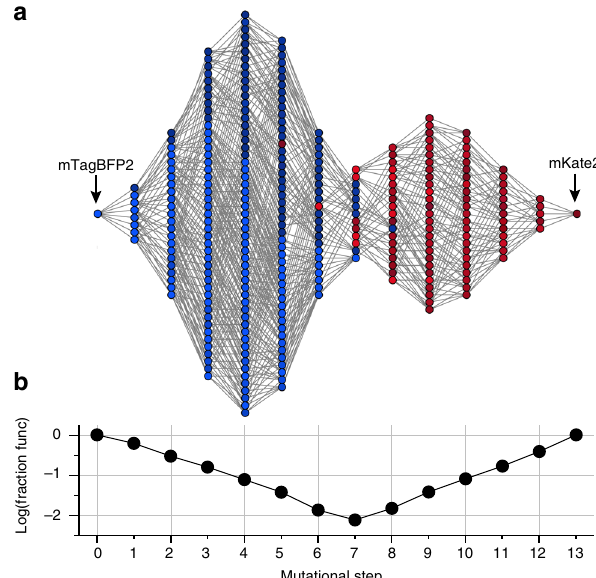
Fig. 6 Single-step connectivity of the sequence space linking mTagBFP2 and mKate2. a A graph of all genotypes comprising a set of sequences connected by single-step variation, as a function of mutational step from mTagBFP2 to mKate2. The brightness threshold for selection of genotypes is at the level of the mKate2. Thus, the sequence space linking the two parental genotypes is fully connected through single mutations without loss of parental function, and the shape of the solution space involves a thin neck near the middle. b The fraction of connected genotypes at each step of mutation reinforces the notion that the space is most constrained at the thin neck, a consequence of severe epistatic constraints at